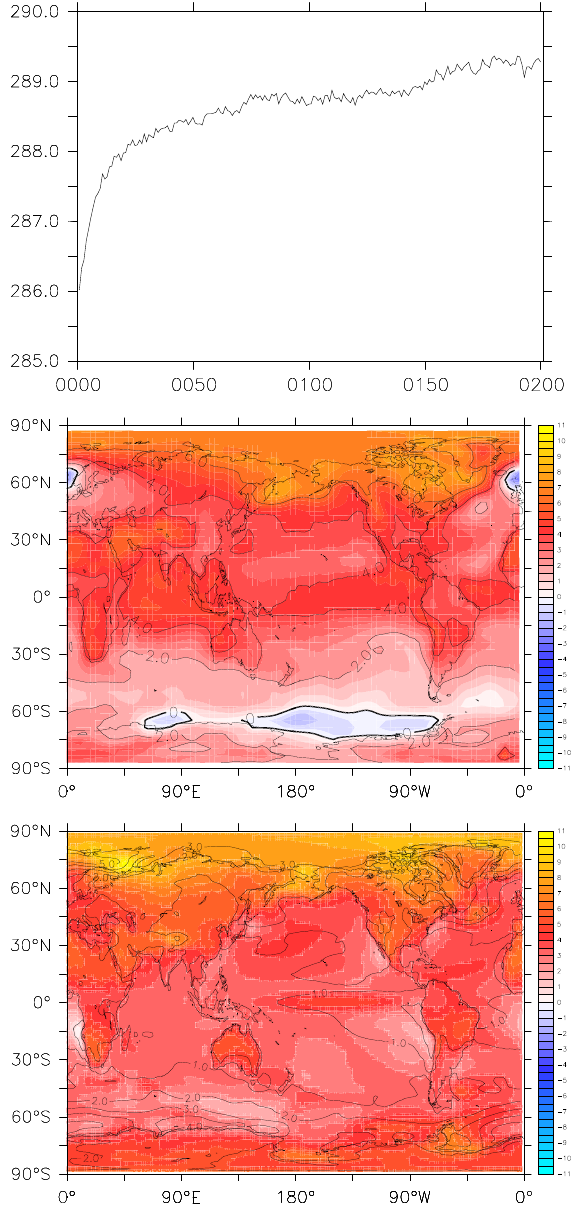
Fig. 19. The annual global mean two meter temperature in K from 1800 to 2100 in each of the SPEEDO ensemble members (thin red, green, light blue, blue and purple lines) and the ensemble mean (thick black line). Also shown are the reanalysis data from 1950 to Fig. 20. The time series of the annual mean two meter temperature Fig. 20. The time series of the annual mean two meter temperature 2008 (red crosses) and the multi-model ensemble mean two meter in SPEEDO (top), the difference in the 100-year mean two meter in SPEEDO (top), the difference in the 100 year mean two meter temperature of all SRES A2 CMIP3 simulations (thin black line). temperature of the 2 · CO 2 experiment and the control run in the sec- temperature of the 2 × CO 2 experiment and the control run in the The one standard deviation spread in the CMIP3 ensemble is shown ond 100years in SPEEDO (centre), and the mean change in the two second 100 years in SPEEDO (centre), and the mean change in the in gray. meter air temperature to a doubling of the CO 2 concentration in the two meter air temperature to a doubling of the CO 2 concentration CMIP3 multi-model ensemble (bottom). The contours in the lower in the CMIP3 multi-model ensemble (bottom). The contours in the panel indicate the standard deviation of the CMIP3 ensemble. All lower panel indicate the standard deviation of the CMIP3 ensemble. quantities are in K. All quantities are in K .